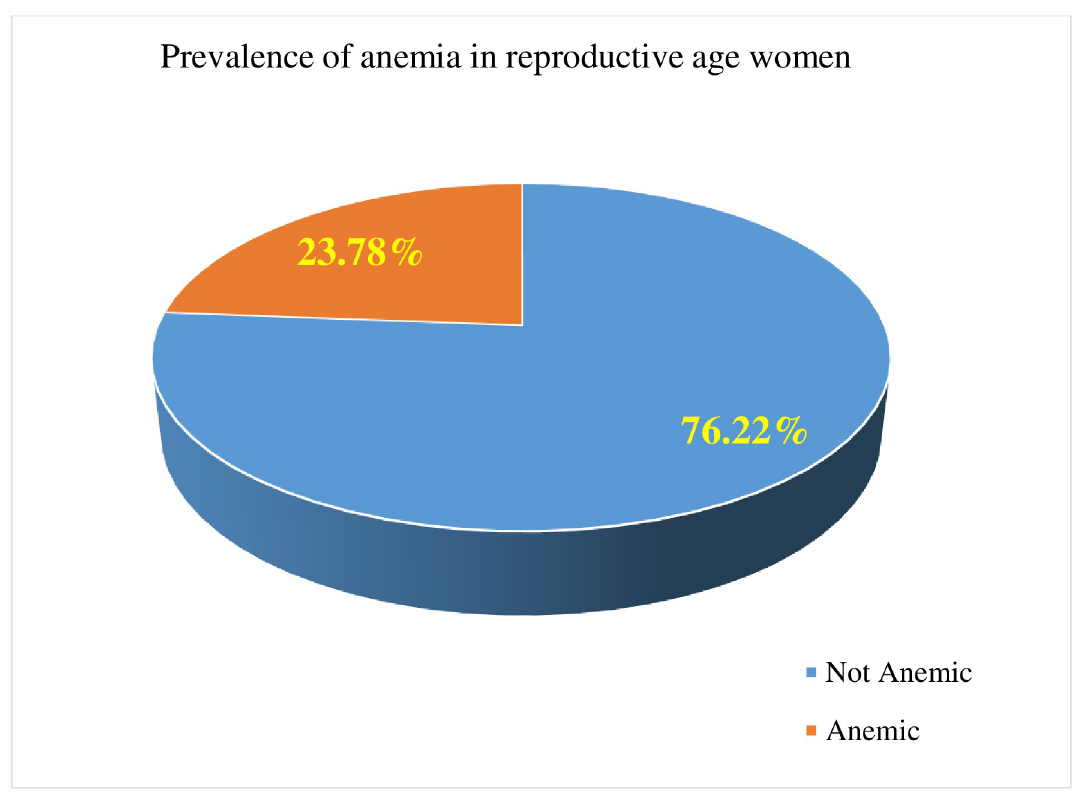
Fig 3. Pie chart which shows the prevalence of anemia in reproductive-age women, EDHS